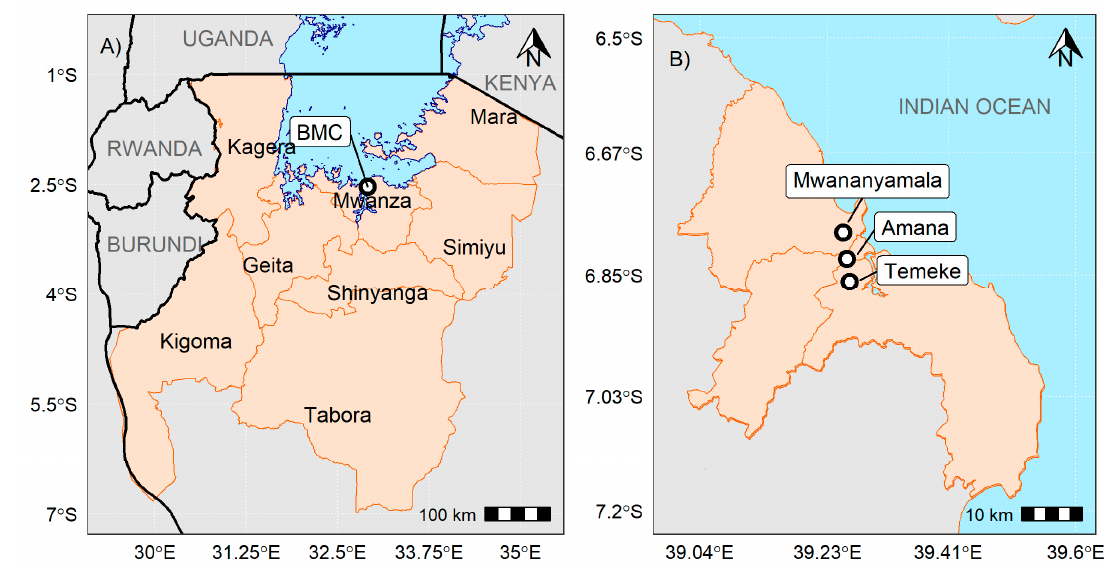
Figure 1. ( A ) is a map of Dar es Salaam showing the districts served by the three hospitals in Dar es Salaam included in this study—Amana Regional Referral Hospitals (ARRH), Mwananyamala Regional Referral Hospitals (MRRH) and Temeke Regional Referral Hospitals (TRRH). ( B ) is a map showing the eight regions in Tanzania served by the Bugando Medical Centre (BMC) in Mwanza as a Regional Referral Hospital (RHH).